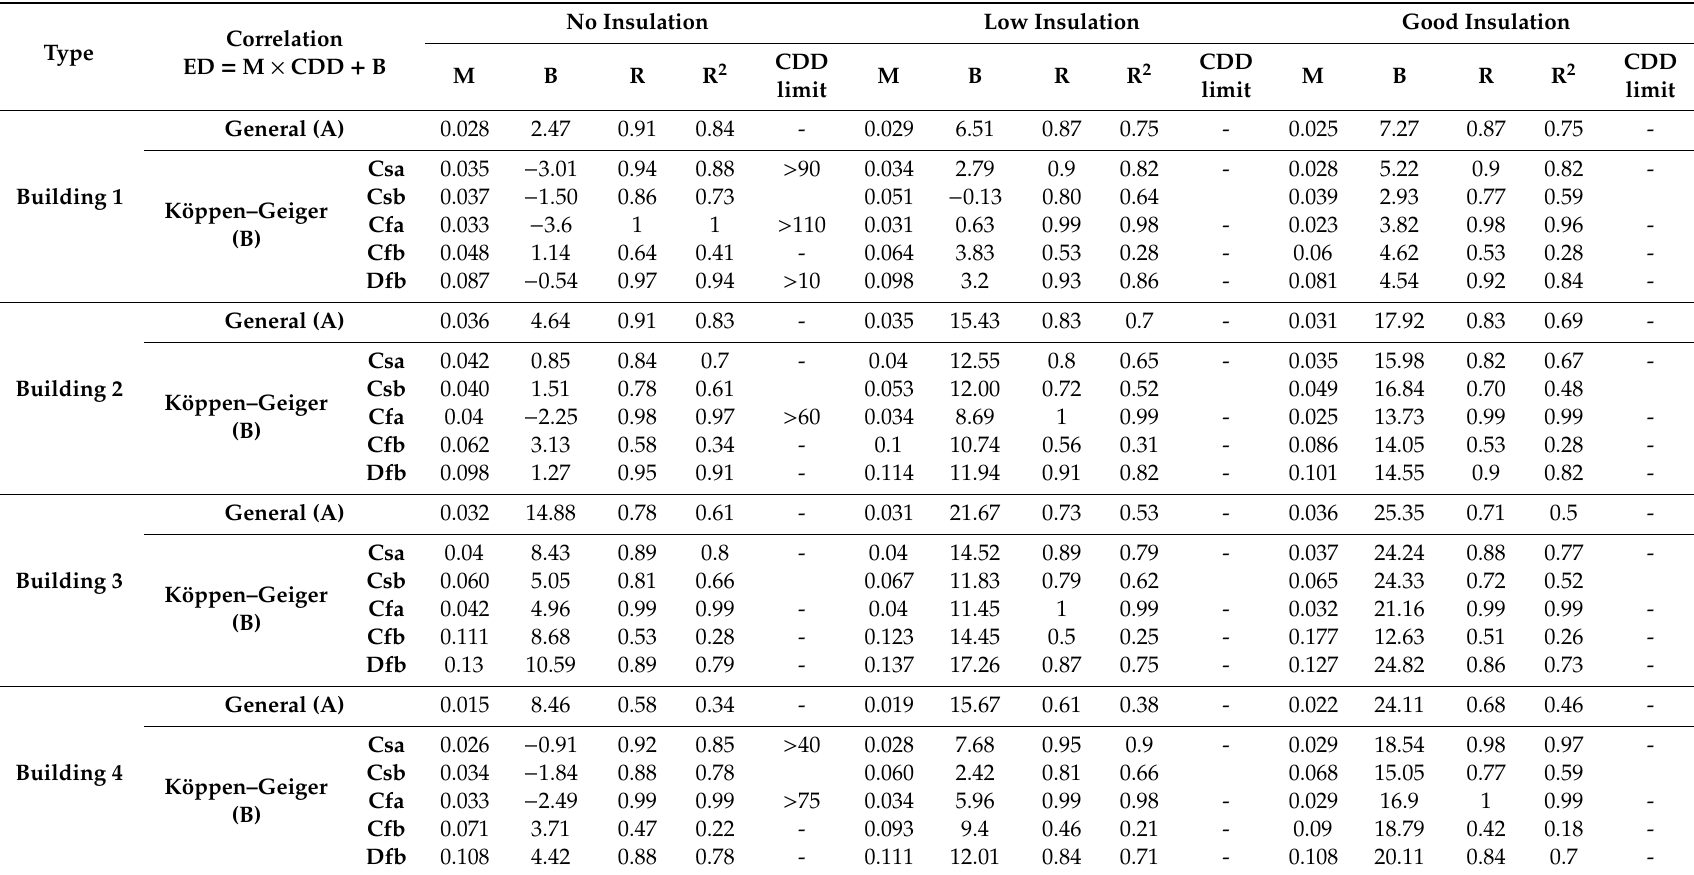
Table 7. Correlations between CDD and cooling energy demand for several residential